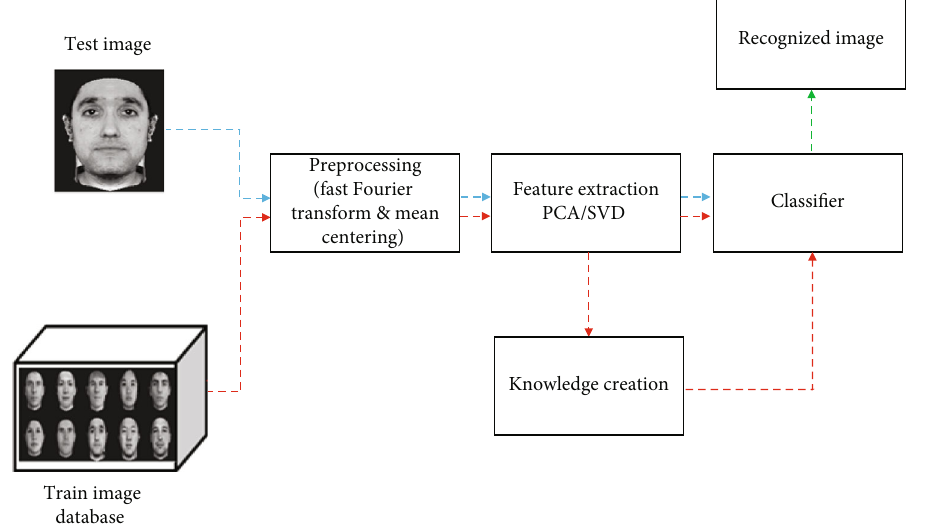
Figure 4: Research